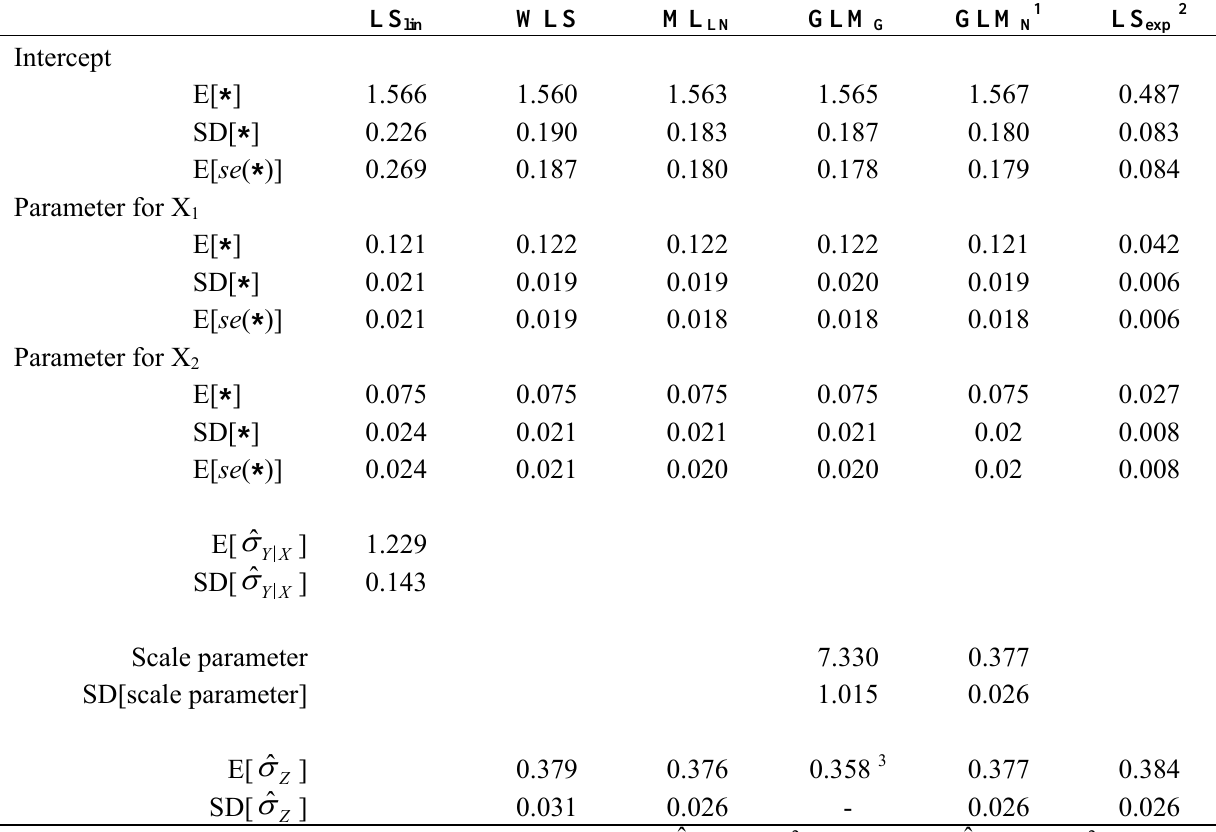
= 1.564, β = 0.122, β = 0 1 2